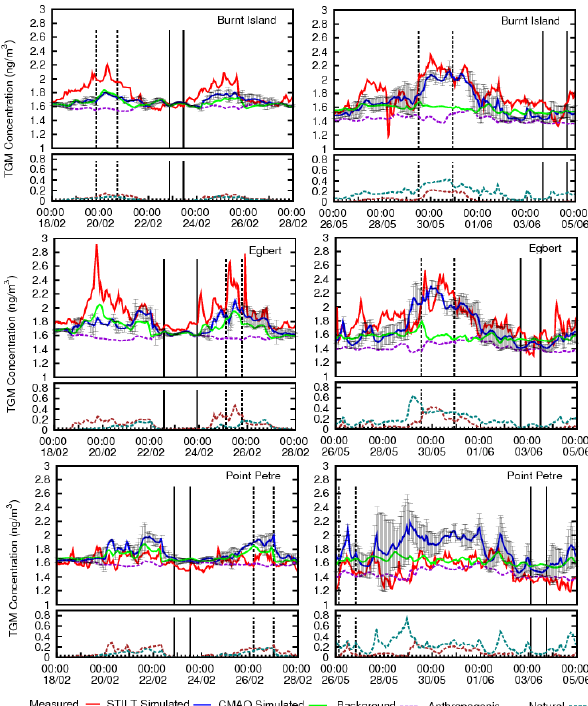
Fig. 3. Total gaseous mercury (TGM) concentration comparisons among observed (red), STILT modeled (blue), and CMAQ mod- eled (green) for two simulation periods: 18–27 February (left) and 26 May–4 June (right), 2002 for Burnt Island (top), Egbert (mid- dle) and Point Petre (bottom). Background concentrations derived from the lateral boundary condition is in violet. The anthropogenic (brown) and natural (teal) contributions to the simulated concentra- tion are shown as dashed curves in the lower panels. Black dashed lines in the vertical designate a selected high Hg episode; black solid lines designate a selected low Hg